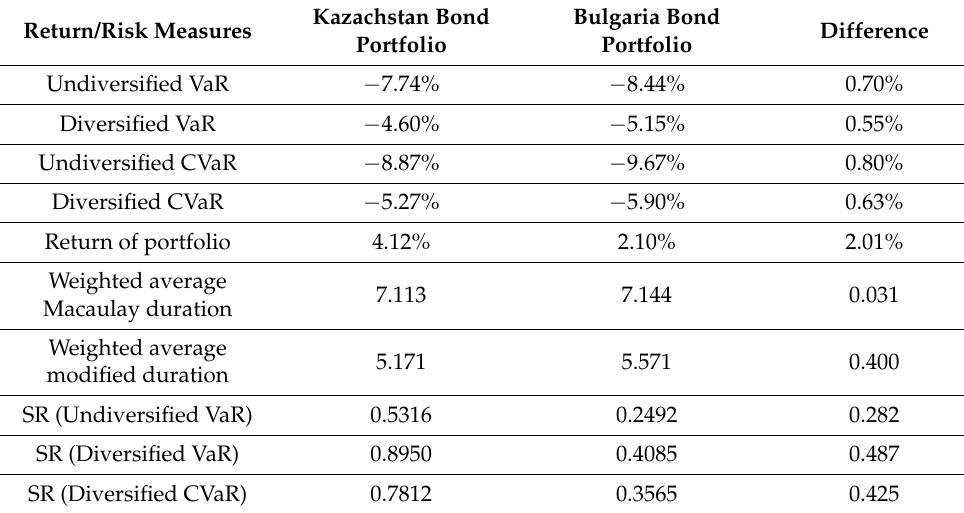
Table 10. Return/risk performance indicators for the bond portfolio of Bulgaria and Kazakhstan (daily